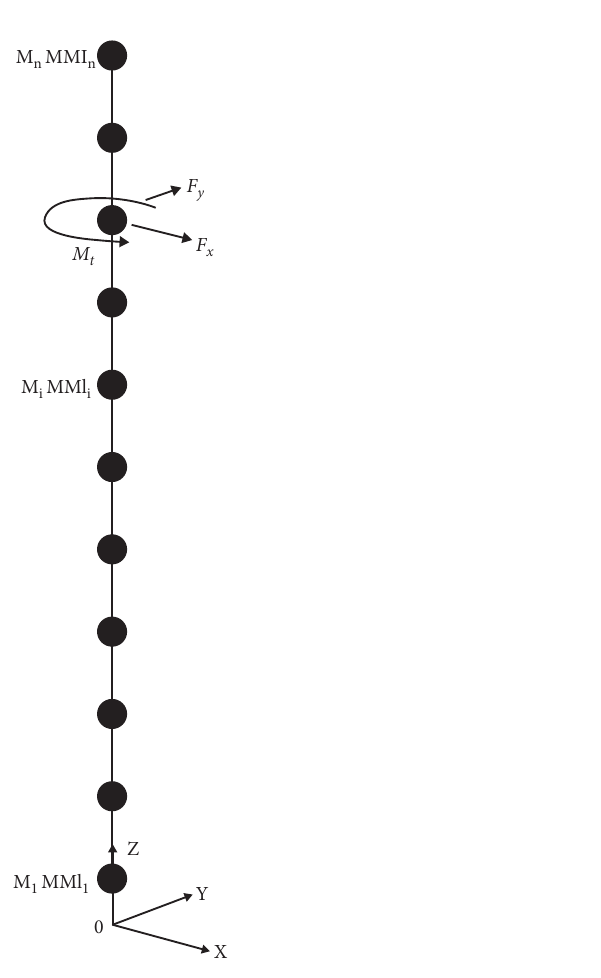
Figure 9: A multiple-degree-of-freedom system with lumped masses in